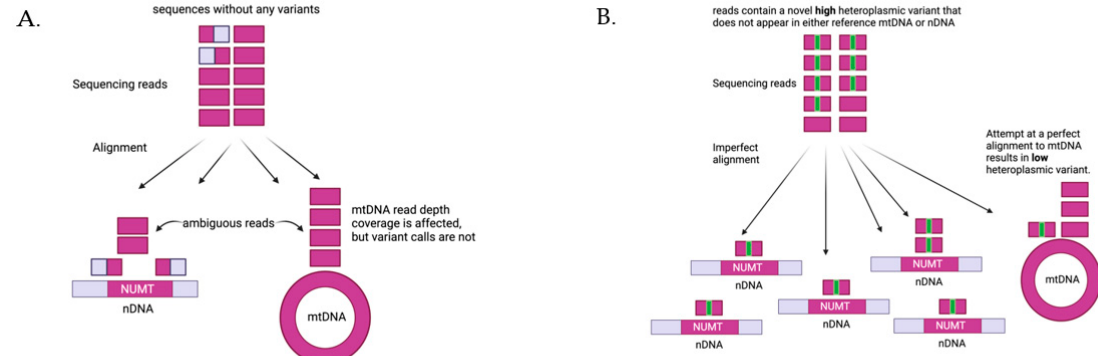
Figure 4. Impact of NUMTs on heteroplasmy quantification. ( A ) If there are no variants in the sequencing reads from mtDNA, the reads will align perfectly to either NUMTs in the nDNA or mtDNA. Reads shorter than the NUMTs sequences will align ambiguously to both NUMTs and mtDNA, and the alignment software has no way of determining exactly where the reads should go. There are several practical options to handle this case (1) drop non-unique alignments, (2) choose an alignment randomly to either NUMTs or mtDNA, or (3) favor alignments to mtDNA. None of these options will affect heteroplasmy computation–since there are no variants by definition, there cannot be any heteroplasmic variants. These options, however, will each give different and erroneous calculations for the read depth of mtDNA coverage. ( B ) Consider reads that originate from mtDNA and possess a novel variant (a variant that does not appear in either the reference nDNA or reference mtDNA). Alignments to either NUMTs or mtDNA will be imperfect, i.e., there will be mismatches. Furthermore, the alignment software cannot accurately determine whether the reads are from mtDNA or nDNA and will assign these reads to both. Again, there are several options, all of which are error prone. If the reads are aligned randomly or with preference to mtDNA, as in this figure, then the variant heteroplasmy level will be underestimated, as some reads will inaccurately be aligned to NUMT regions. The more copies of this NUMT there are, the more reads will erroneously align to NUMTs, thus further reducing the heteroplasmy estimate. Similar issues arise if the reads originally originated from NUMTs instead of mtDNA, as reads could erroneously align to the mtDNA, inflating the estimate of heteroplasmy.